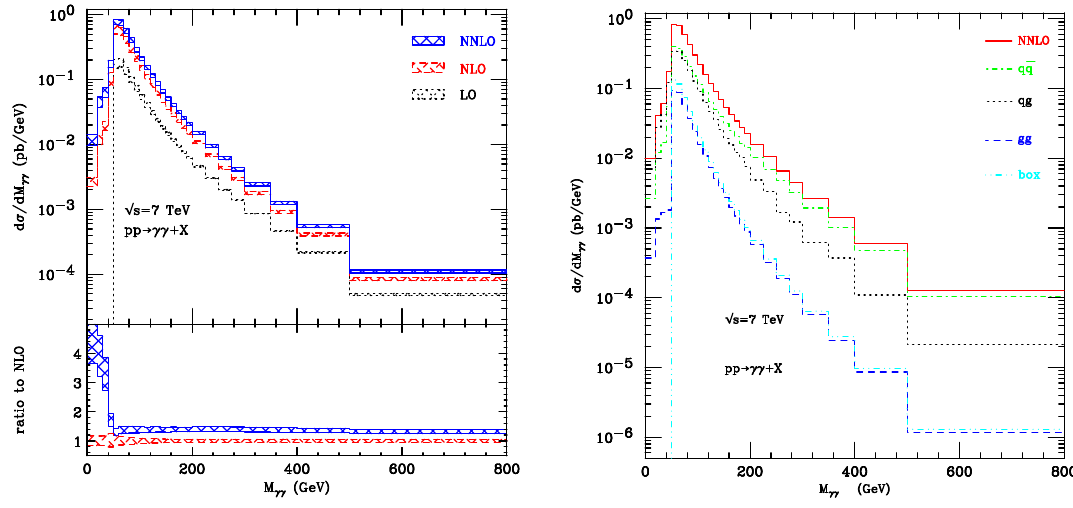
Figure 11 . The differential cross section dσ/dM γγ with the same photon kinematical cuts as in table 2. The main panel in the left-hand side shows the LO (black dotted), NLO (red dashed) and NNLO (blue solid) results, with the corresponding scale dependence. The lower subpanel presents the NNLO K factor (including its scale dependence) and the relative scale dependence at NLO. The panel in the right-hand side shows the NNLO result at central scales and its decomposition in the contributions of different initial-state partonic channels: q ¯ q (green dot-dashed), qg (black dotted) and gg (blue dashed). The separate contribution of the box gg γγ squared amplitude is → also shown (light-blue